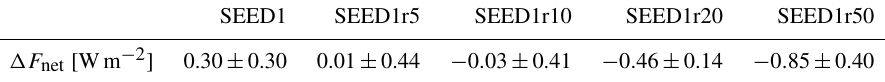
Table 4. Top-of-the-atmosphere net radiative balance ( F net ) anomalies in Wm − 2 for cirrus seeding with 1 INPL − 1 with varying INP radius and the ± 2 standard deviation range for fixed SST simulations.